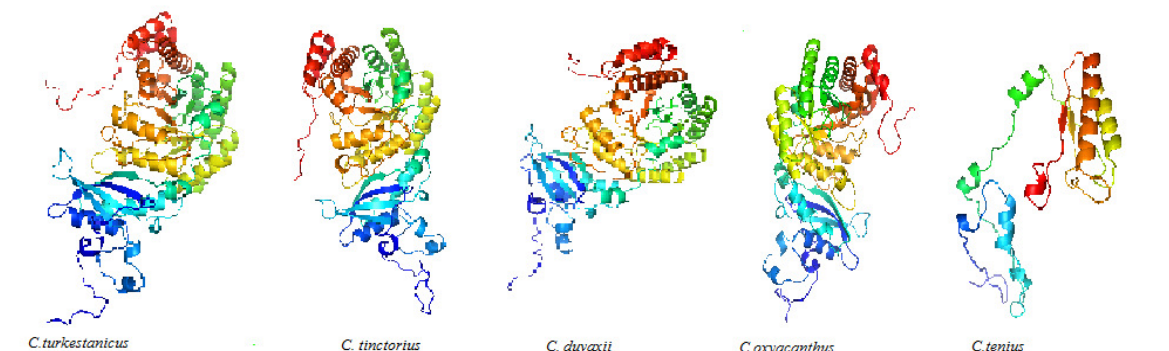
Fig. 4. The comprehensive 3D structures of Carthamus ssp. RuBisCO proteins. The visual data were obtained from PSIPRED software and analysed using PyMOL